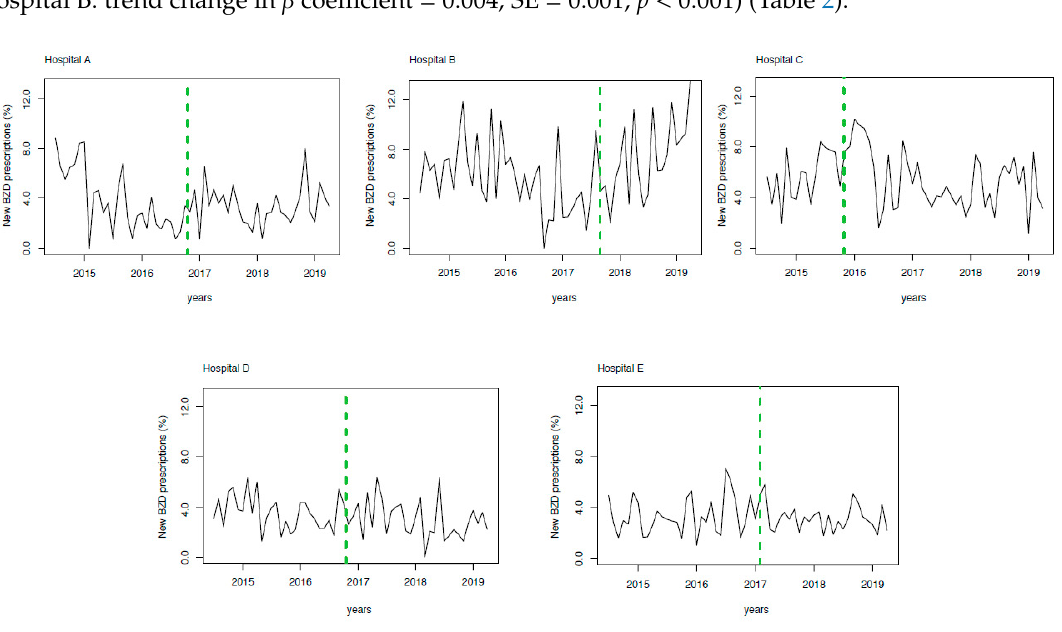
Table 2. Interrupted time-series regression analysis of new benzodiazepine prescriptions among hospitals in the network.